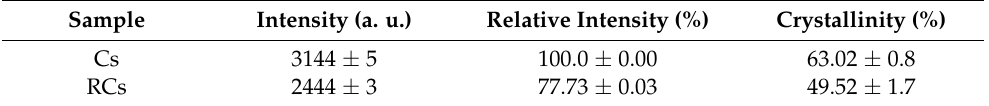
Table 2. Representative values of XRD.